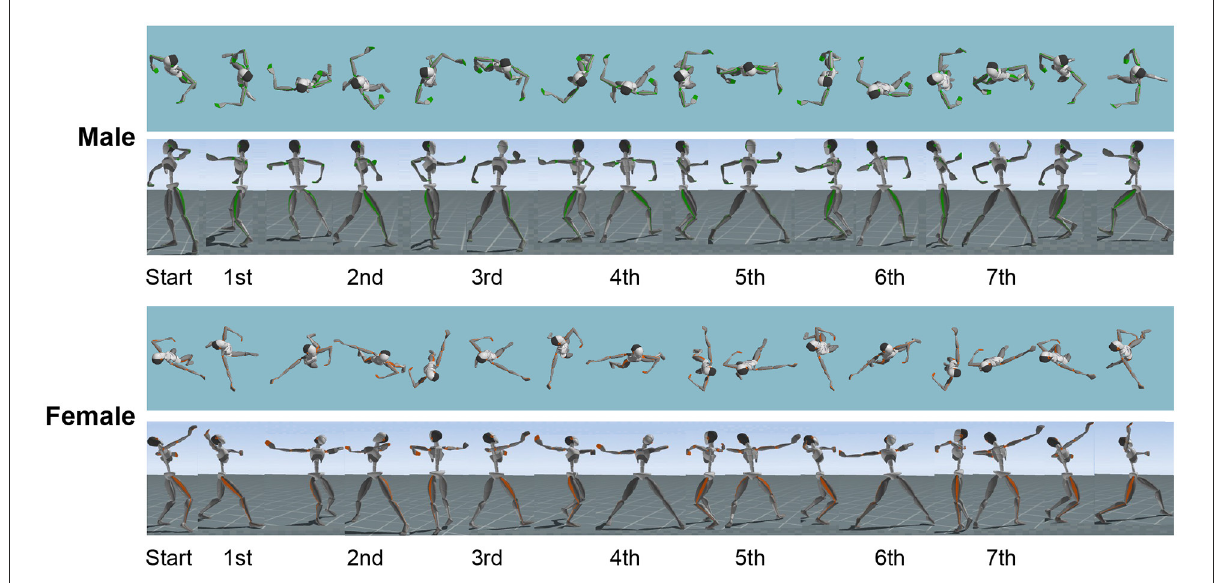
FIGURE1 Explanation of spin movement in waltz. The steps from the start to the 7th step are shown. Top: Male, Bottom: